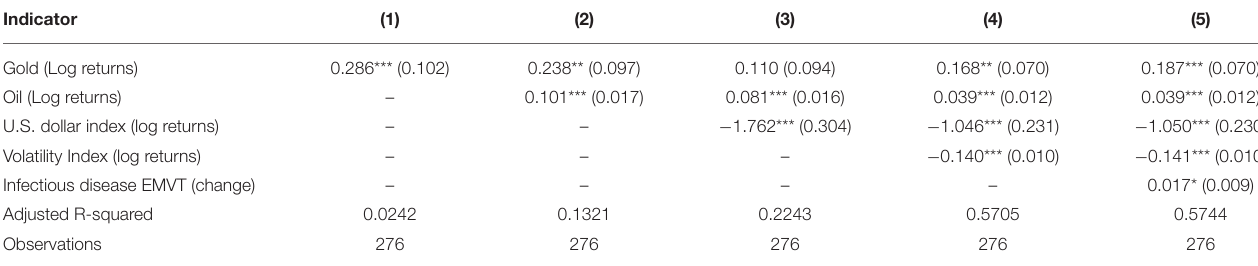
TABLE 3 | Results of the OLS estimations.